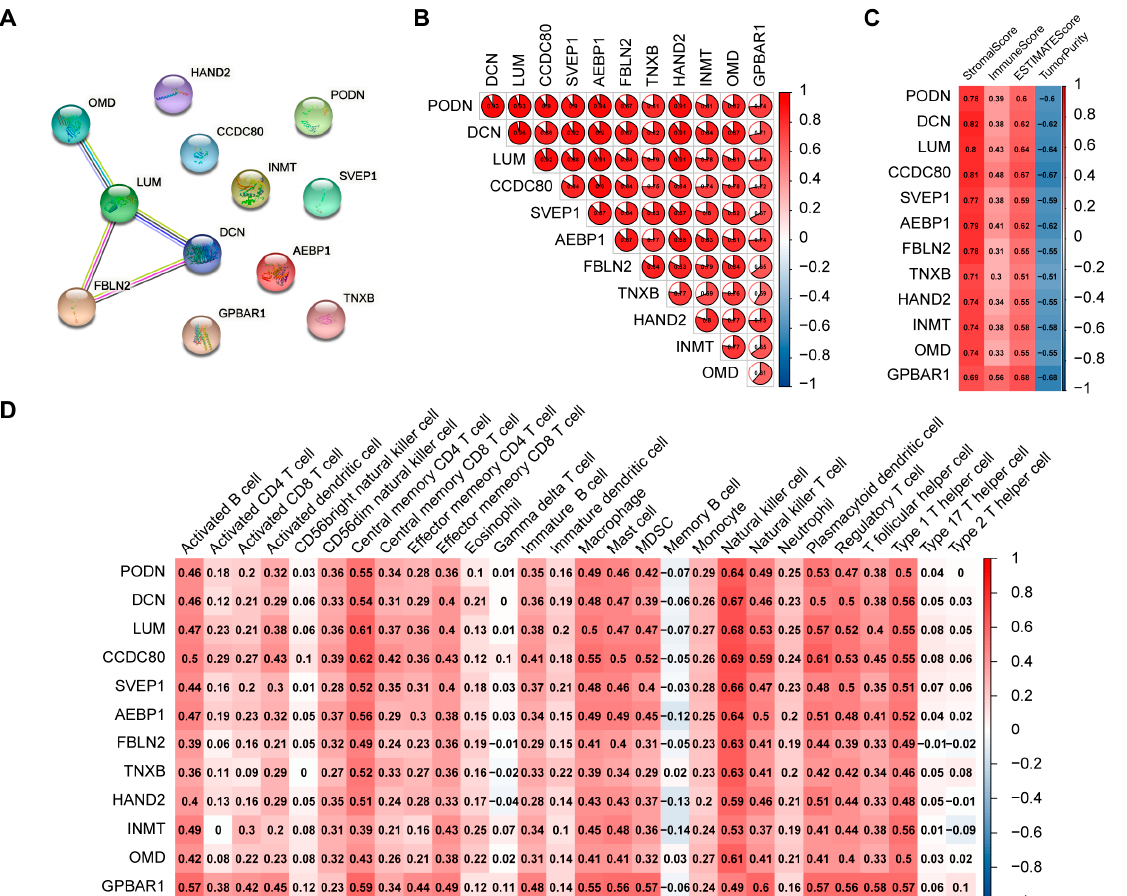
Figure 6. Determination of the functions of FBLN2 . ( A ) Survival curves of patients with different expression levels of FBLN2 . ( B ) Multivariate Cox regression analysis of the 12 hub genes. ( C ) Corre- lation analysis between FBLN2 and the abundance of tumor-infiltrating lymphocytes through TISIDB. ( D ) Comparison of the proportion of immune cells by CIBERSORT in patients with different